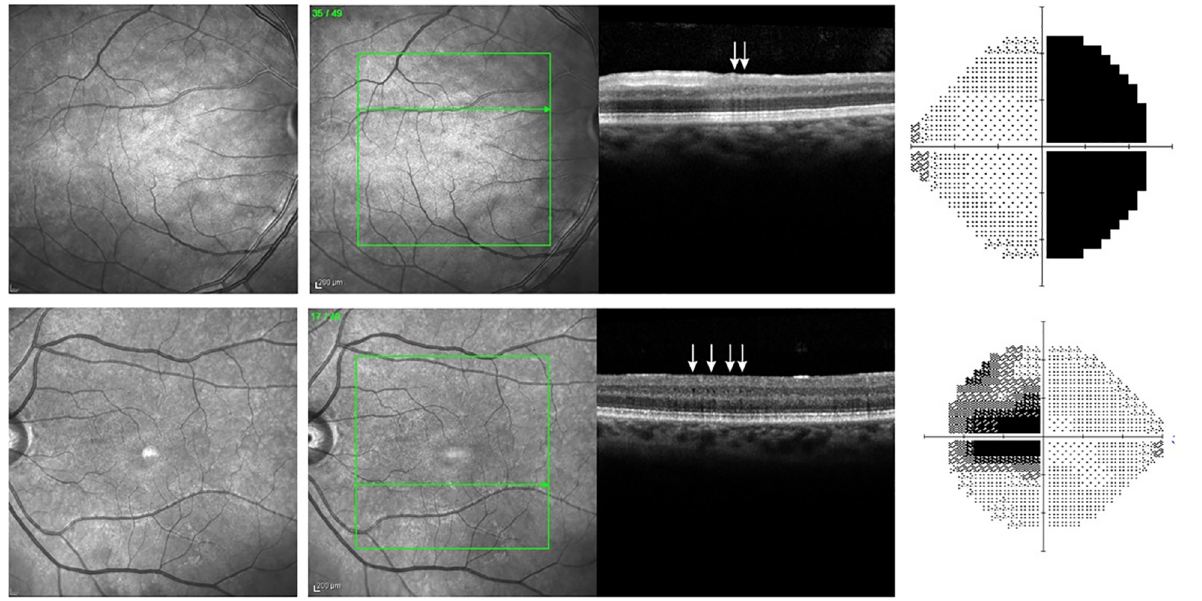
Fig 4. Near infrared reflectance imaging (two first columns) of 2 patients labeled as having no hyporeflective abnormalities (HA-MMA+) by the examiners. Optical coherence tomography scans showing microcysts in the inner nuclear layer (white arrows, third column). The two patients had dense temporal VF defects (right